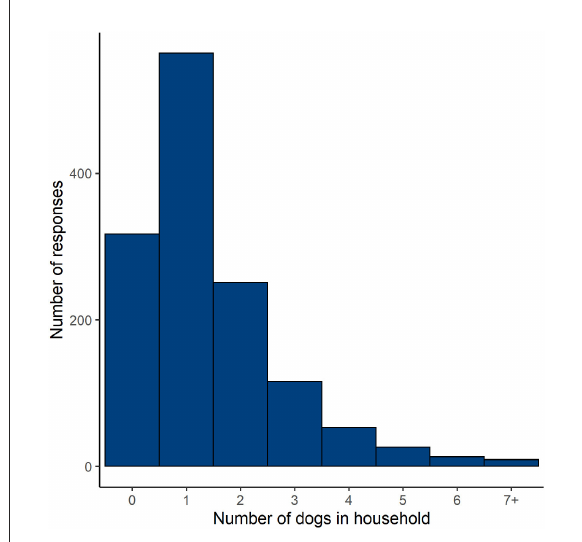
FIGURE1 Histogram of the number of owned dogs per household from a survey of 1,349 respondents in Costa Rica.